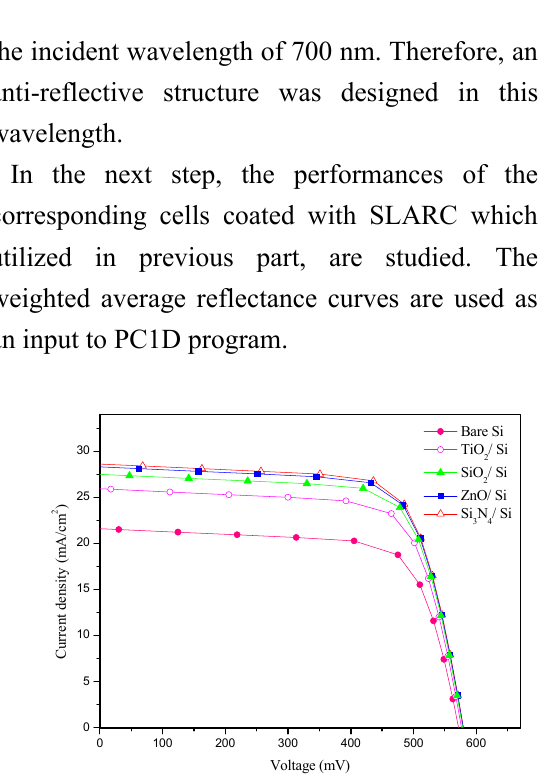
Fig. 3 . (I –V) curves of the silicon solar cell without and with TiO